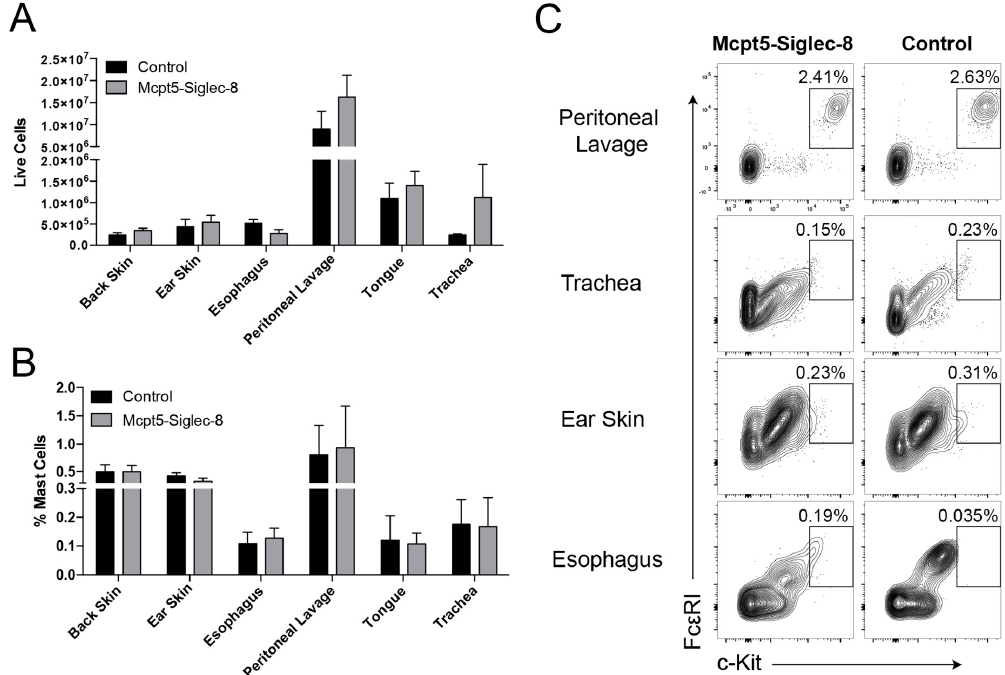
Figure 3. Equal mast cell numbers in control and Mcpt5-Siglec-8 mice across multiple tissues. ( A ) Quantification of total live cells isolated from various tissues; ( B ) average frequency of mast cells (CD45 + CD11b − Fc ε RI + c-Kit + of live cells) in the tissues of Mcpt5-Siglec-8 (Mcpt5-Cre +/ − SIG8 +/ − , n = 3) and control ( n = 4: WT, n = 1 and Mcpt5-Cre − / − SIG8 +/ − , n = 3) mice; and ( C ) representative flow cytometry plots of dispersed tissues showing live CD45 + CD11b − cells with a gate for Fc ε RI + c-Kit + cells. Data in ( A ) and ( B ) are from three independent experiments, and the mean ± SEM of n = 3–4 are displayed. No significant differences between the groups were identified (two-way